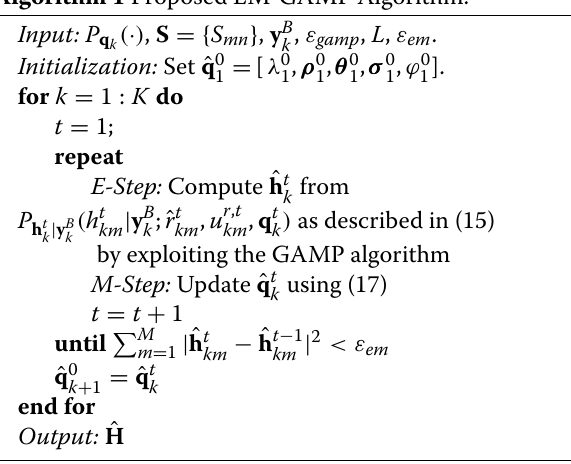
Algorithm 1 Proposed EM-GAMP